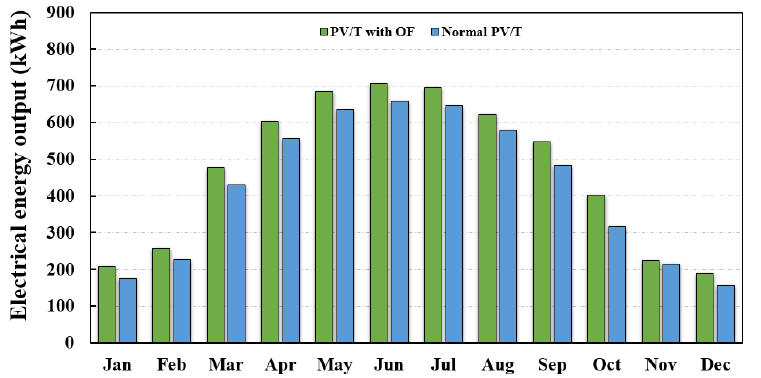
Figure 5. Electrical energy output.